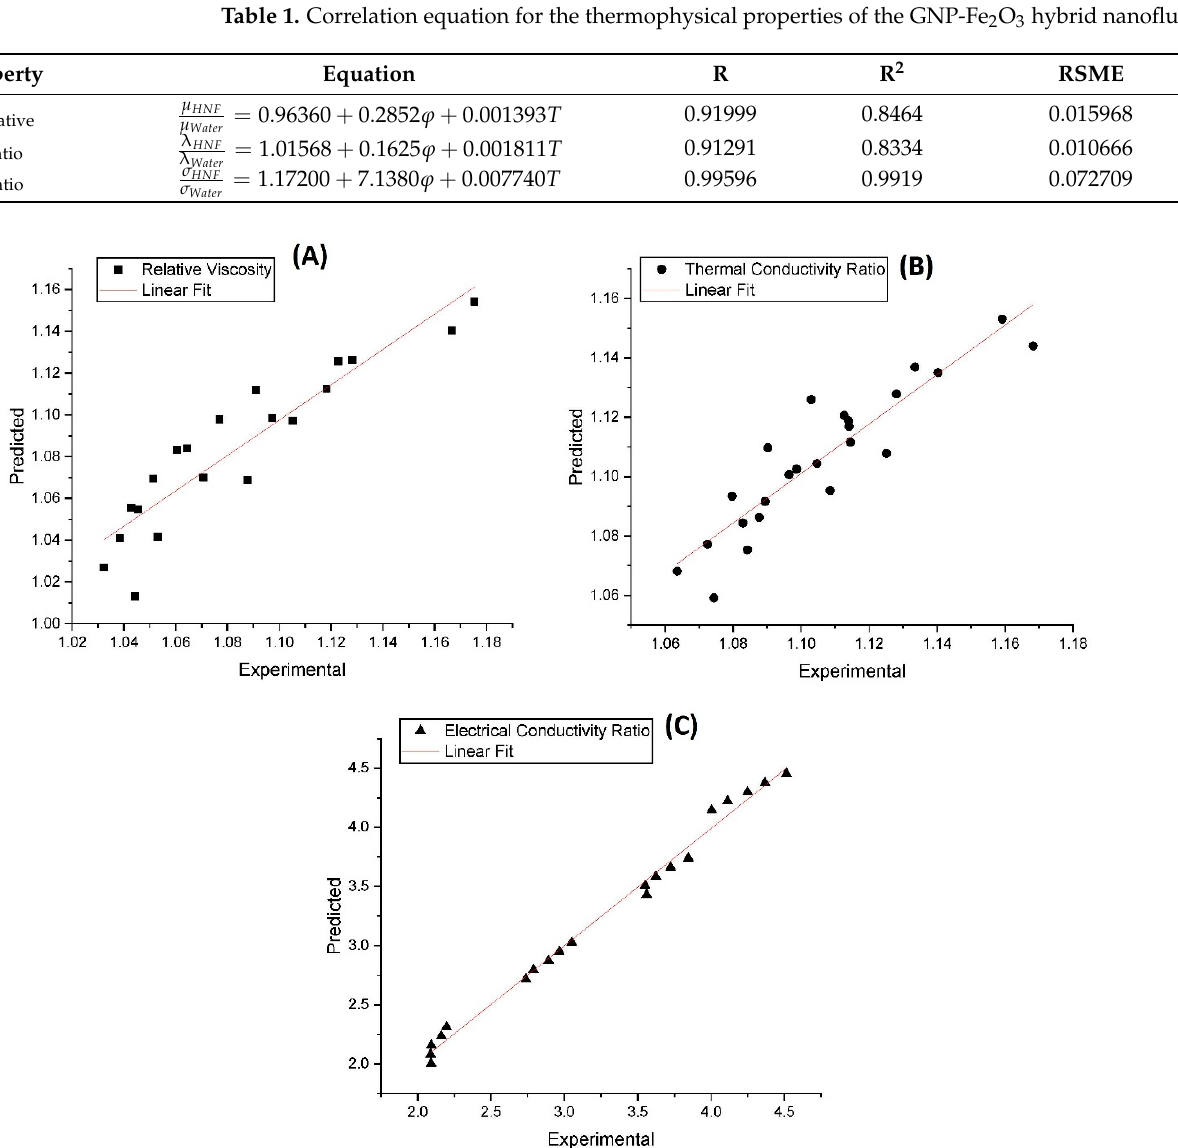
Figure 18. Linear fitting of the experimental and predicted values of the thermophysical properties. ( A ) Relative viscosity; ( B ) Thermal Conductivity Ratio; ( C ) Electrical Conductivity Ratio. Table 1. Correlation equation for the thermophysical properties of the GNP-Fe 2 O 3 hybrid nanofluid.